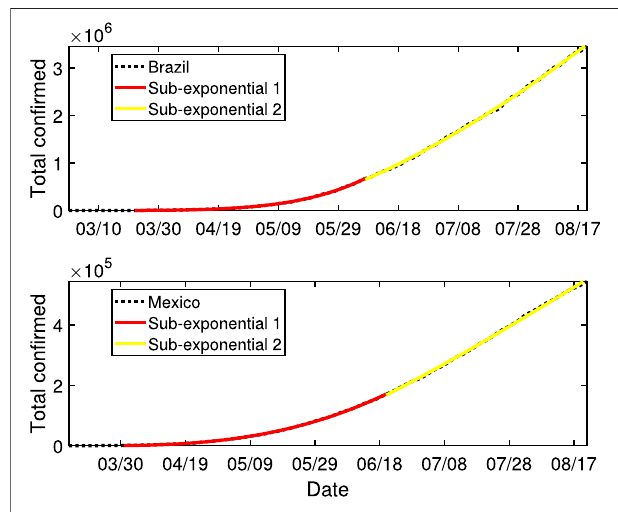
FIGURE 3 | The fi ttingresultsofBrazilandMexico.Theblackdashedcurves represent the real data. The red and yellow curves represent the two different sub-